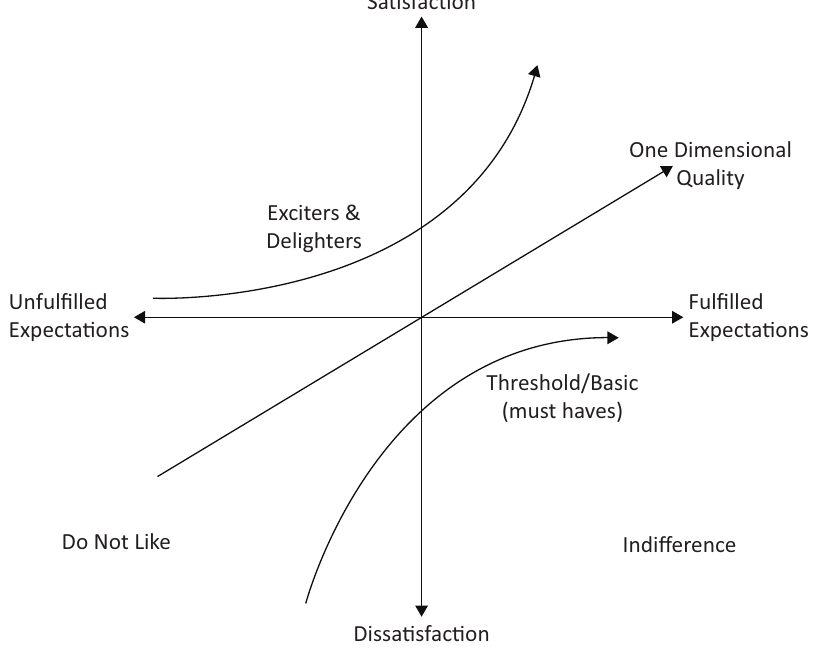
Figure 1. Kano’s model. Source: Kano et al. (1984, p. 41). Urban Planning, 2022, Volume 7, Issue 2, Pages